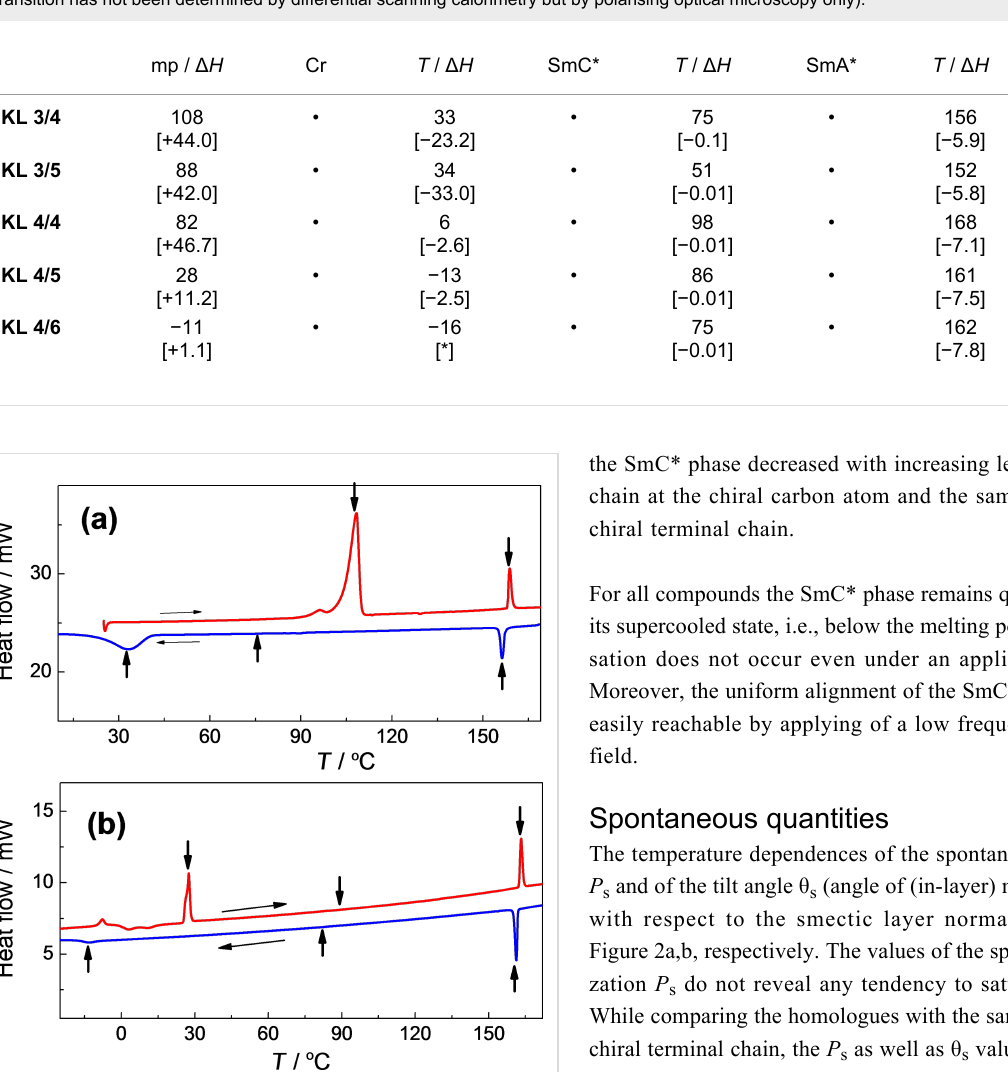
Table 1: Sequence of phases, phase transition temperatures T [°C], transition enthalpies Δ H [J/g] (measured on cooling with DSC [5 K min − 1 ]) and melting points mp [°C] (measured on heating) for all studied compounds. (“•” indicates that the phase exists, value in brackets indicates that the phase transition has not been determined by differential scanning calorimetry but by polarising optical microscopy only).